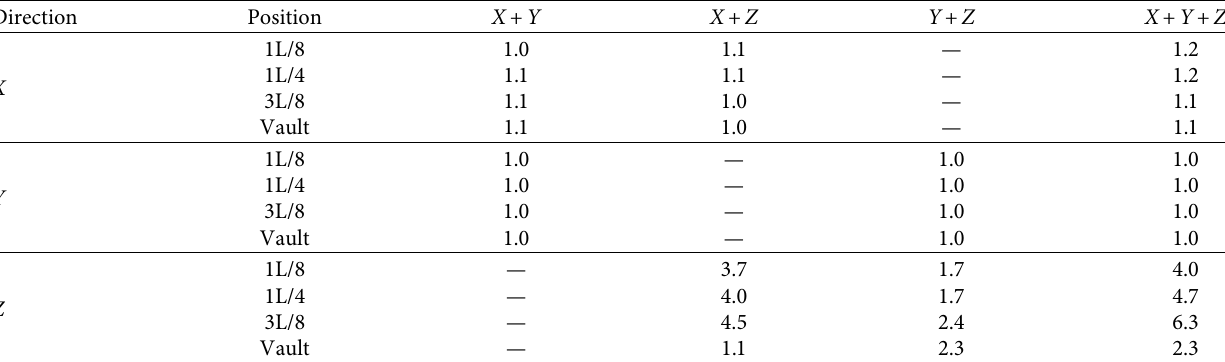
Table 5: Upper chord displacement